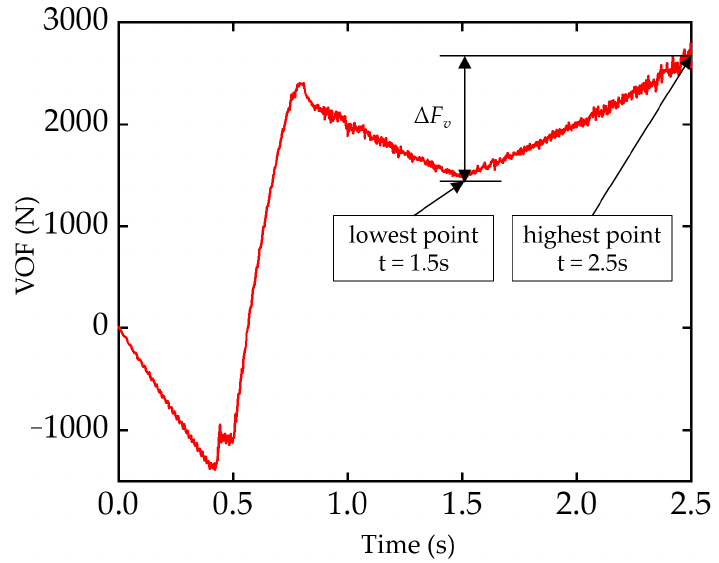
Figure 5. The VOF at different times.